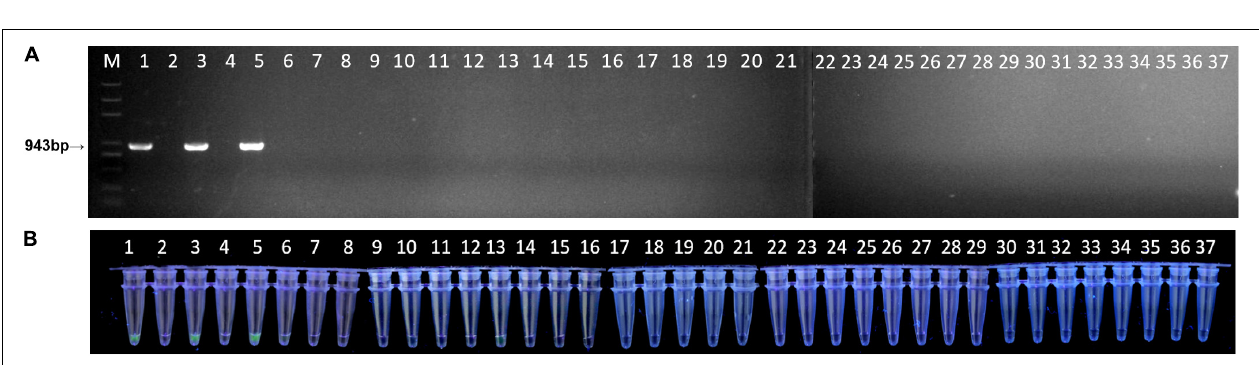
FIGURE 6 | Field detection of natural peach leaves with the simplified RPA/Cas12a-fluorescence assay. (A) A total of 37 peach leaf samples were investigated with PCR amplification. (B) The simplified RPA/Cas12a-fluorescence assay was applied for the same 37 leaf